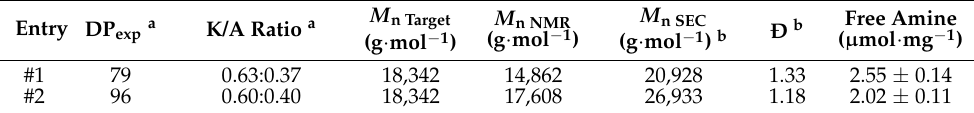
Table 2. Polypeptide synthesized by ROP of NCA amino